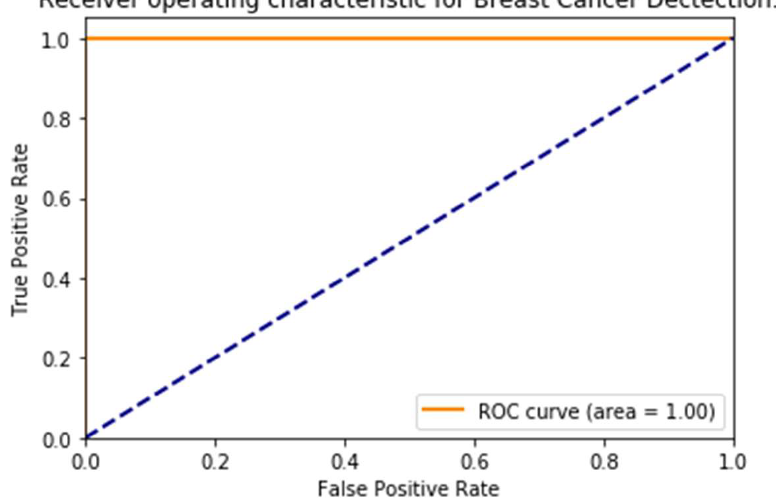
Figure 16. A receiver operating characteristic (ROC) curves of our prediction, where the top left corner of the plot can be interpreted as “ideal” point (a false positive rate of zero, and a true positive rate of one).